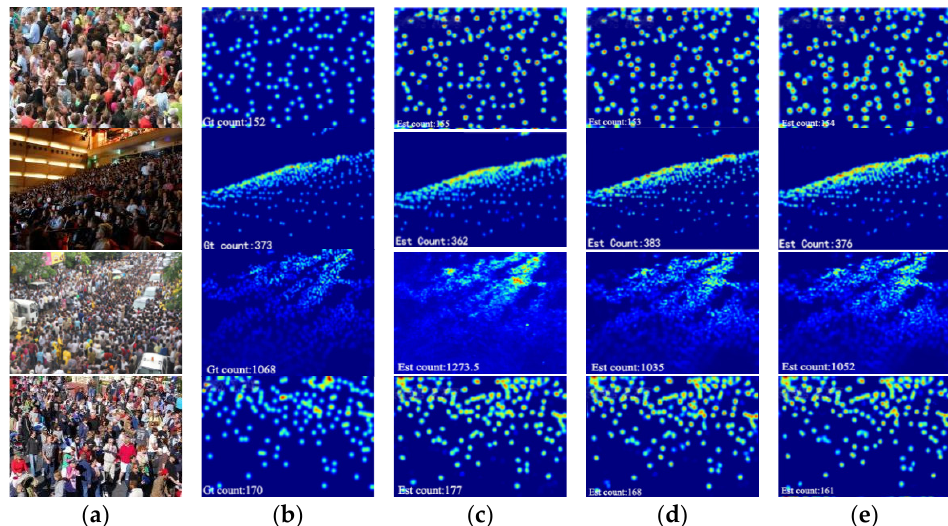
Figure 3. Visual comparisons of different methods on ShanghaiTech Part_A. ( a ): the sample images. ( b ): the ground truth. ( c – e ) correspond to the estimated density maps from MCNN, CAT ‐ CNN, and the proposed SASNet, respectively.